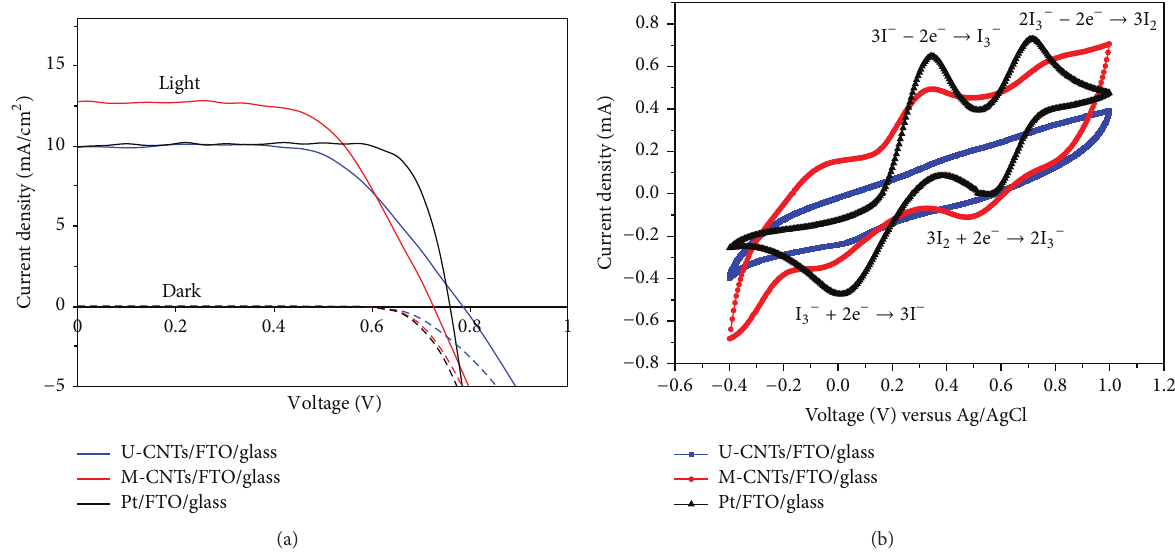
Figure 5: (a) Plot of the photocurrent density ( 𝐽 ) versus the photovoltage ( 𝑉 ) of the Pt/FTO, U-CNTs/FTO, and M-CNTs/FTO glass DSSCs. (b) Cyclic voltammograms of the Pt/FTO, U-CNTs/FTO, and M-CNTs/FTO films on glass substrates in acetonitrile solution of 10 mM LiI, 1mM I 2 , and 0.1 M LiClO 4 at the scan rate of 20